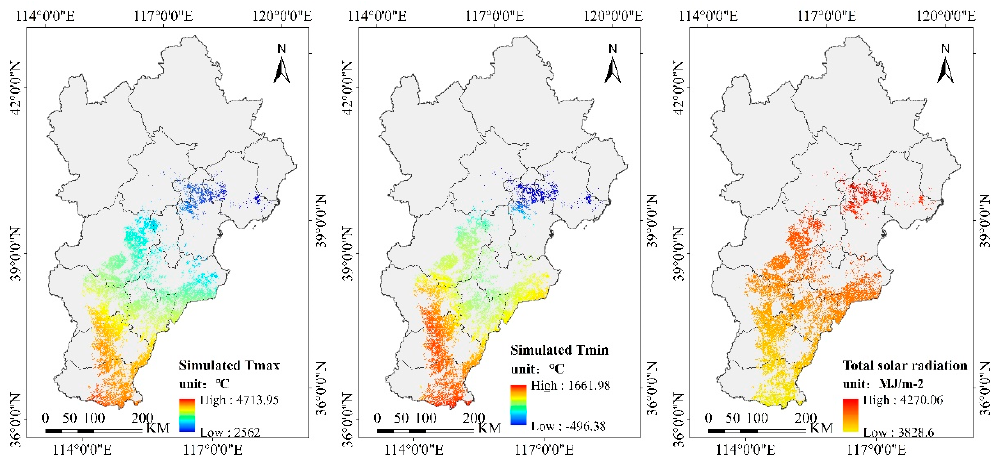
Figure 6. Temperature and total solar radiation distribution during the winter wheat growth period in JJJ.